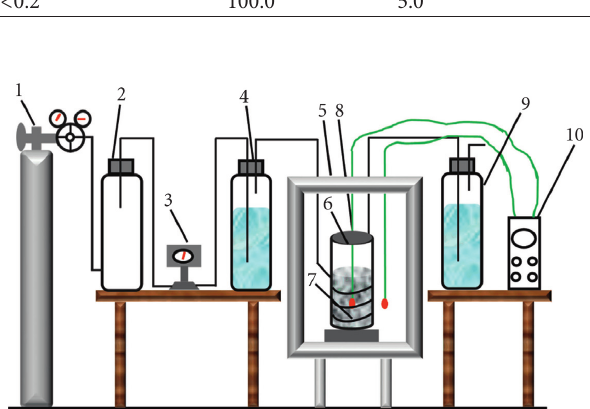
Figure 2: Experimental apparatus: 1: oxygen cylinder; 2: buffering bottle; 3: flow meter; 4: humidifier; 5: automatic heating incubator; 6: reactor; 7: ores; 8: temperature probe; 9: poisonous gas ab- sorption bottle; 10: automatic temperature recorder.